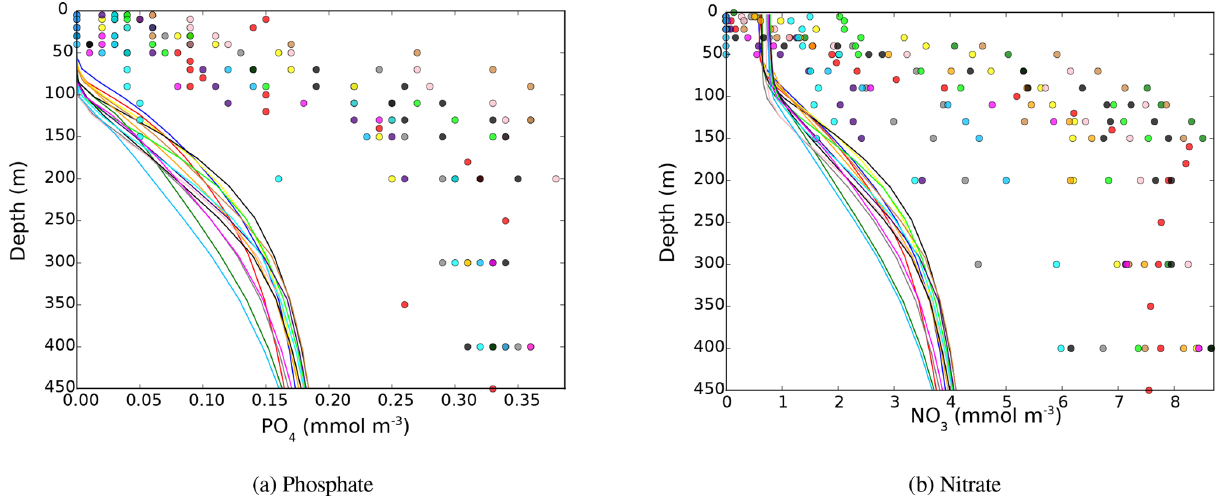
Figure A2. Average phosphate (a) and nitrate (b) profiles in May for the years 1991 to 2005 at the DYFAMED station in the Ligurian Sea (43.4277 ◦ N, 7.2522 ◦ E). Dots represent data points (Marty et al., 2002; Faugeras et al., 2003). Lines represent the HIS/A2 simulation. Colors represent individual